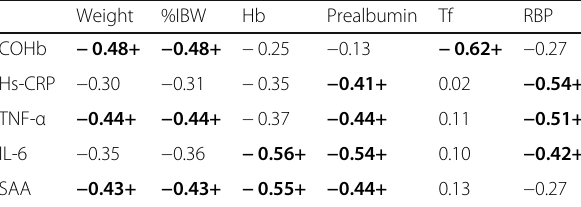
Table 5 Associations among the biomarkers at change from baseline to post